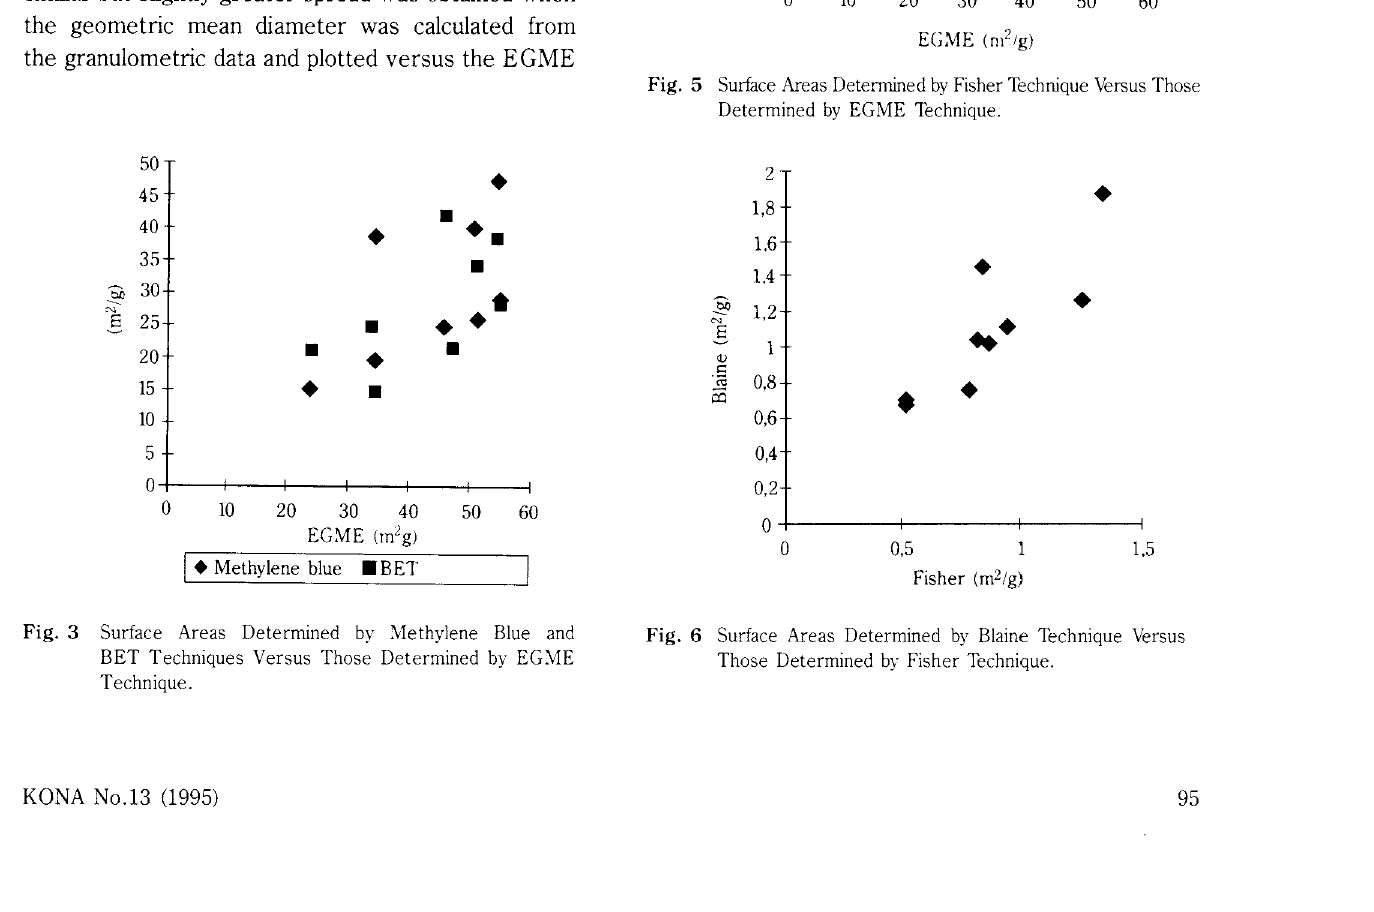
Fig. 6 Surface Areas Determined by Blaine Technique Versus Those Determined by Fisher